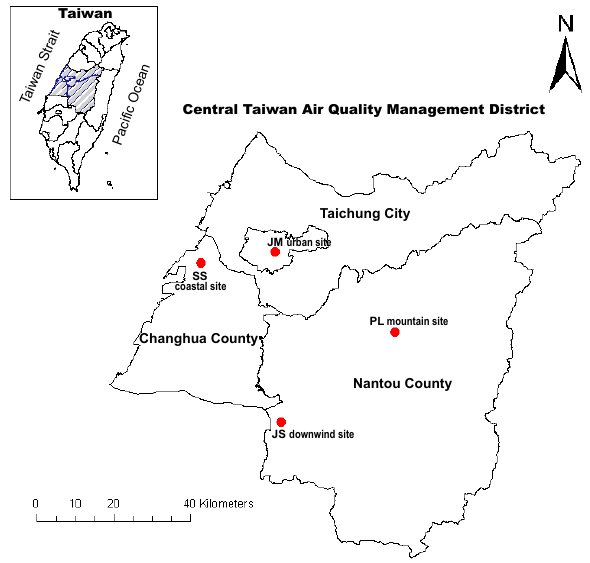
Fig. 1. Map of the four observation sites in the Central Taiwan Air Quality Management